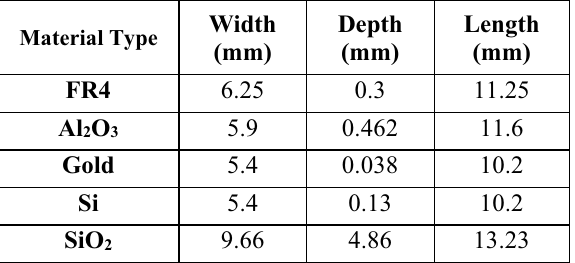
Table 1 : Physical properties of various significant materials. Material Type